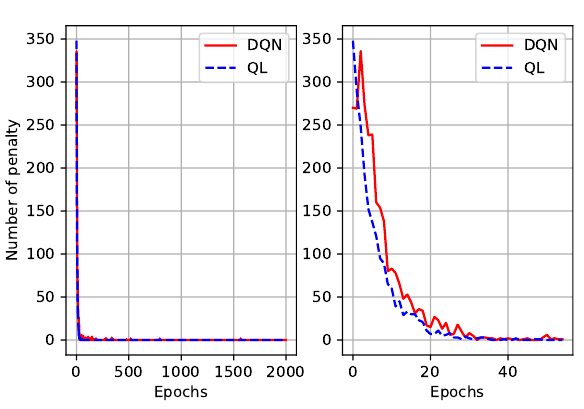
Figure 4. The number of penalties during